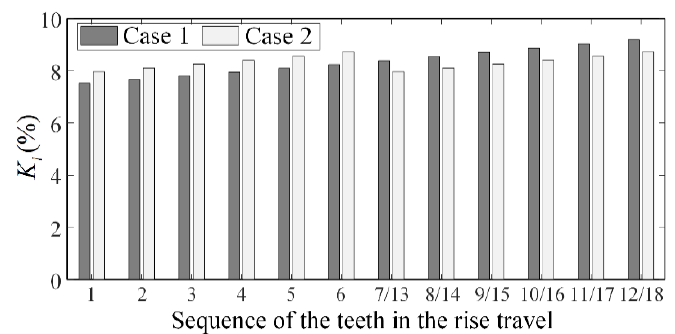
Figure 14. Load distribution factor.